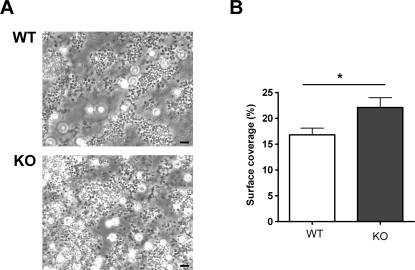
PKCθ negatively regulates thrombus formation on collagen under flow in vitro.Whole blood was passed over a collagen-coated coverslip at 1000 s−1 for four minutes then observed by phase contrast microscopy (A). Surface coverage was measured and is shown in B as mean±SEM for three independent experiments. Bar indicates 10 µm.